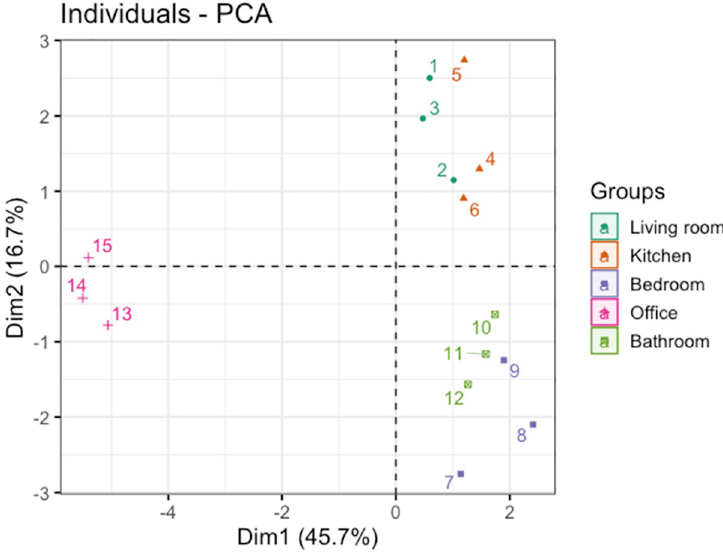
Fig 2. Scores plot from PCA on sensor array responses after 48 h deployment in different rooms within a single